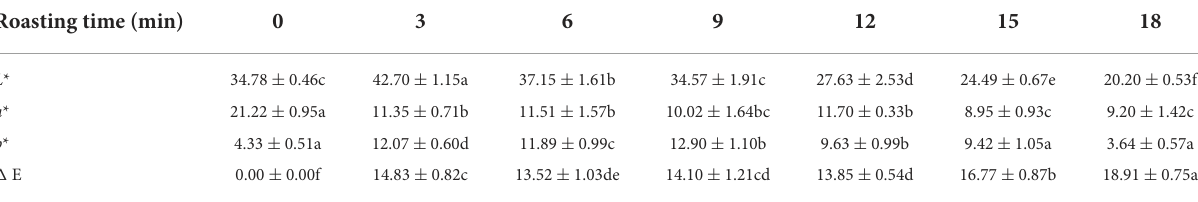
TABLE 1 Lightness value ( L * ), redness value ( a * ) and yellowness value ( b * ) of the roasted beef. Roasting time